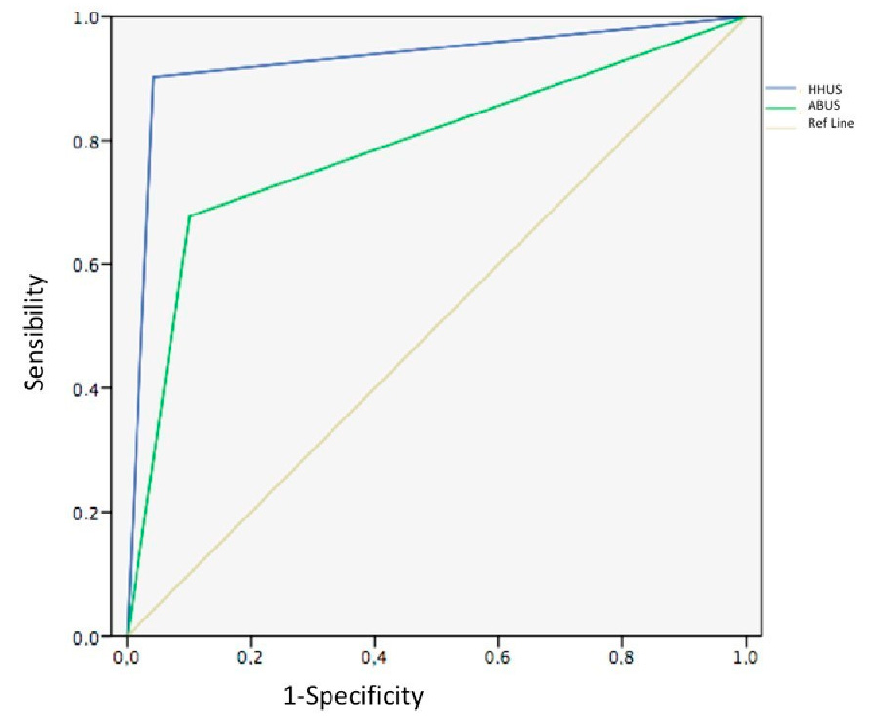
Figure 1. ROC curve. HHUS examination presents a better accuracy than ABVS ( p < 0.05).